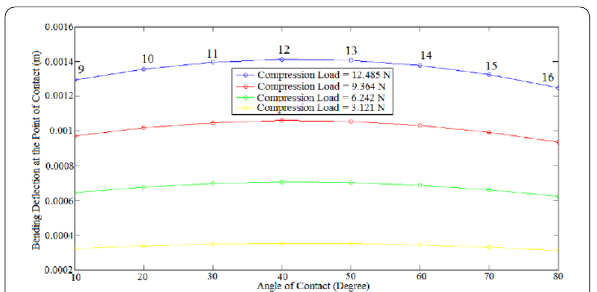
Figure 20 Bending deflection against the contact angle of path No.